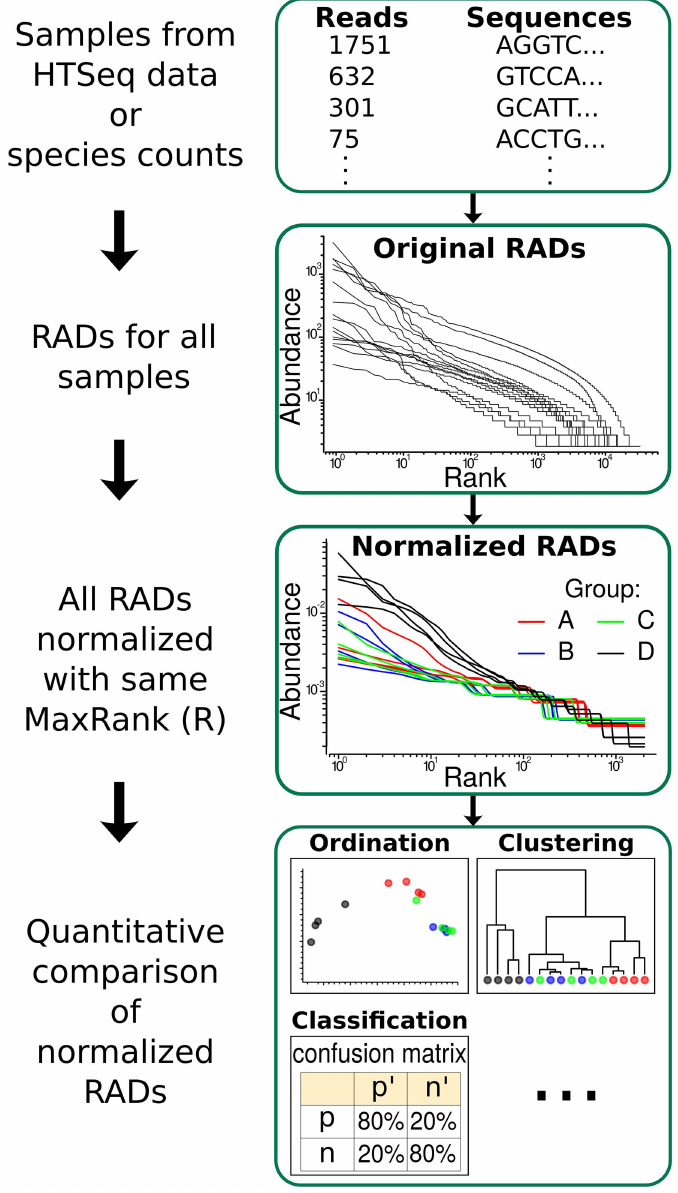
Fig 3. General process employed in this work. Flowchart of procedurefrom originalspecies/abundances or sequence/reads data (top box) to originalRADs, then to NRADs, and analysesbasedon